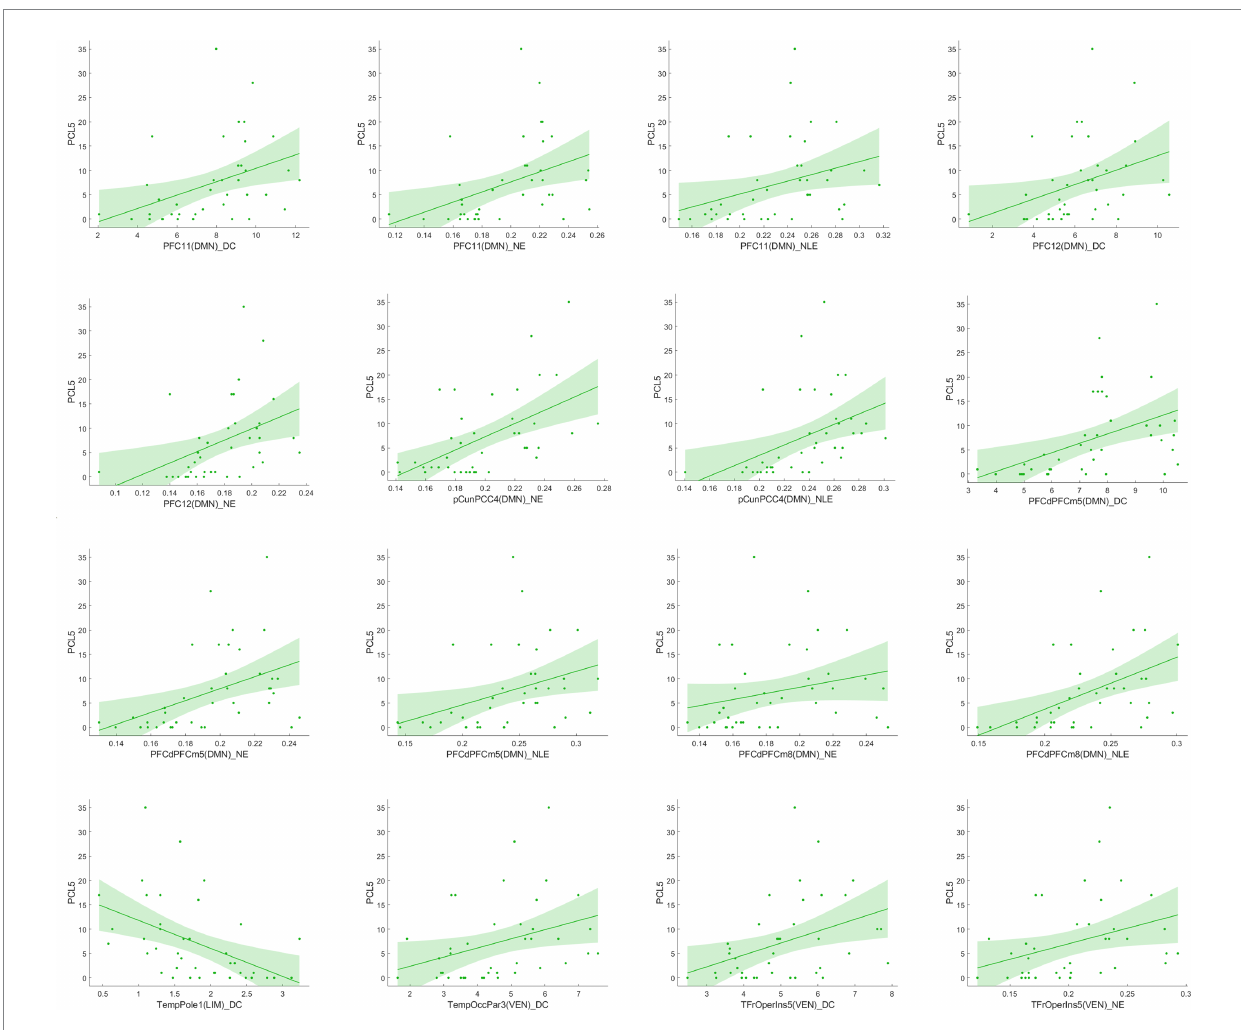
FIGURE 7 Correlation analysis between significant network metric changes and clinical characteristics after 1 year follow-up among EPRT-